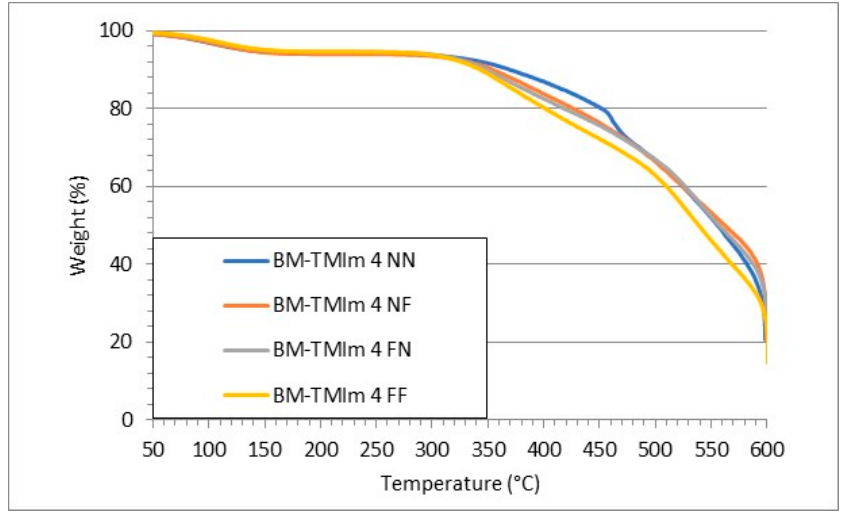
Figure 4. Weight loss as a function of temperature measured by TGA.